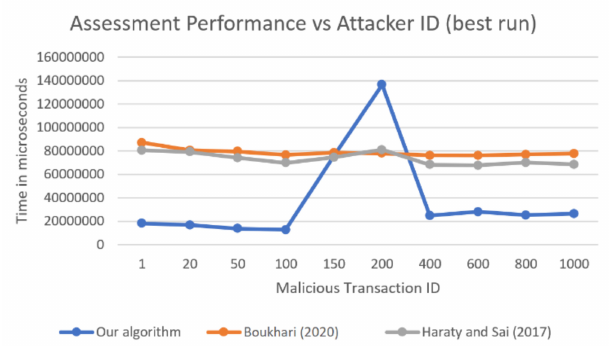
Figure 3. Comparison of the best times of three algorithms as a function of the malicious transac- tion ID.